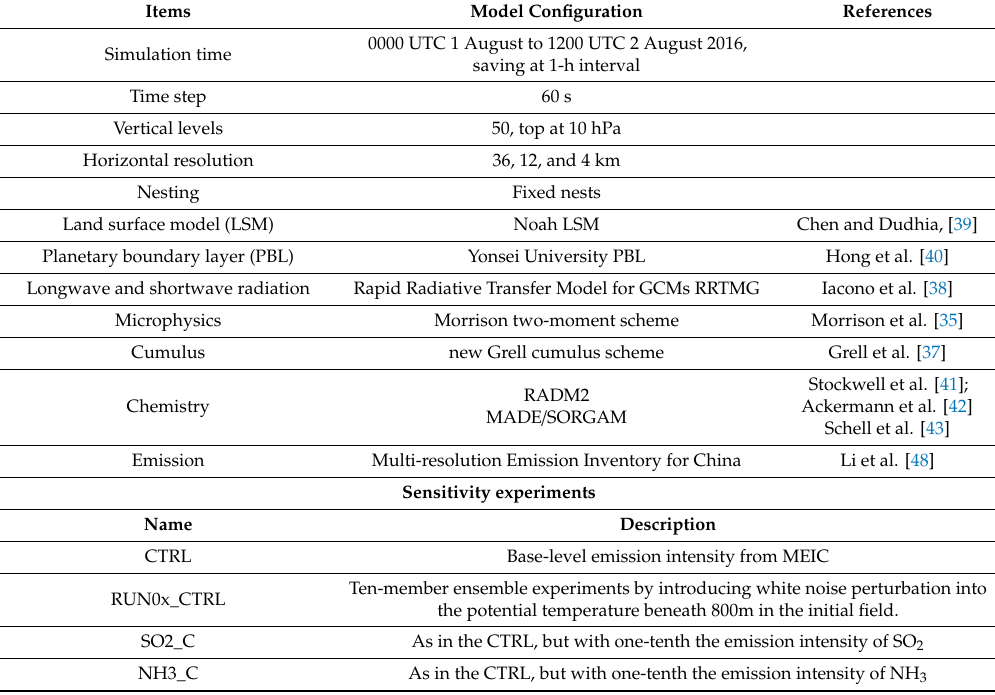
Figure 2. The spatial distributions of mean hourly emission intensity of ( a ) SO 2 and ( b ) NH 3 − 2 − 1 (mol km h ) in August. ( c ) The time-series of area-averaged mixing ratio of SO 2 and NH 3 − 2 − 1 (mol km h ) within the black circle in ( a ). Table 1. Model setups for numerical experiments.